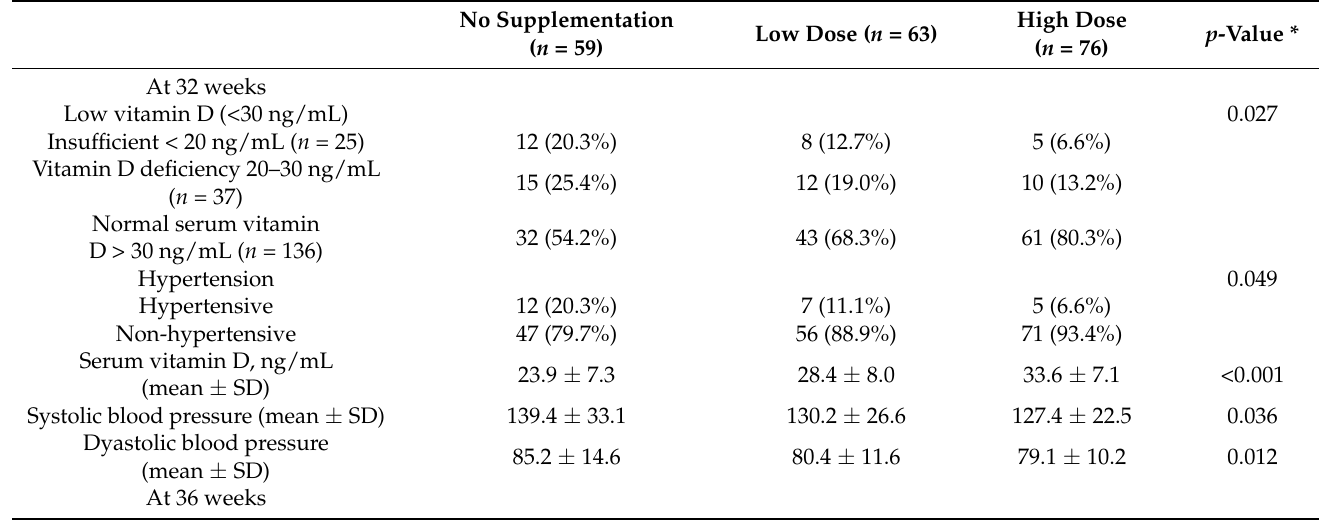
Table 4. Patient records at 32 weeks and 36 weeks of